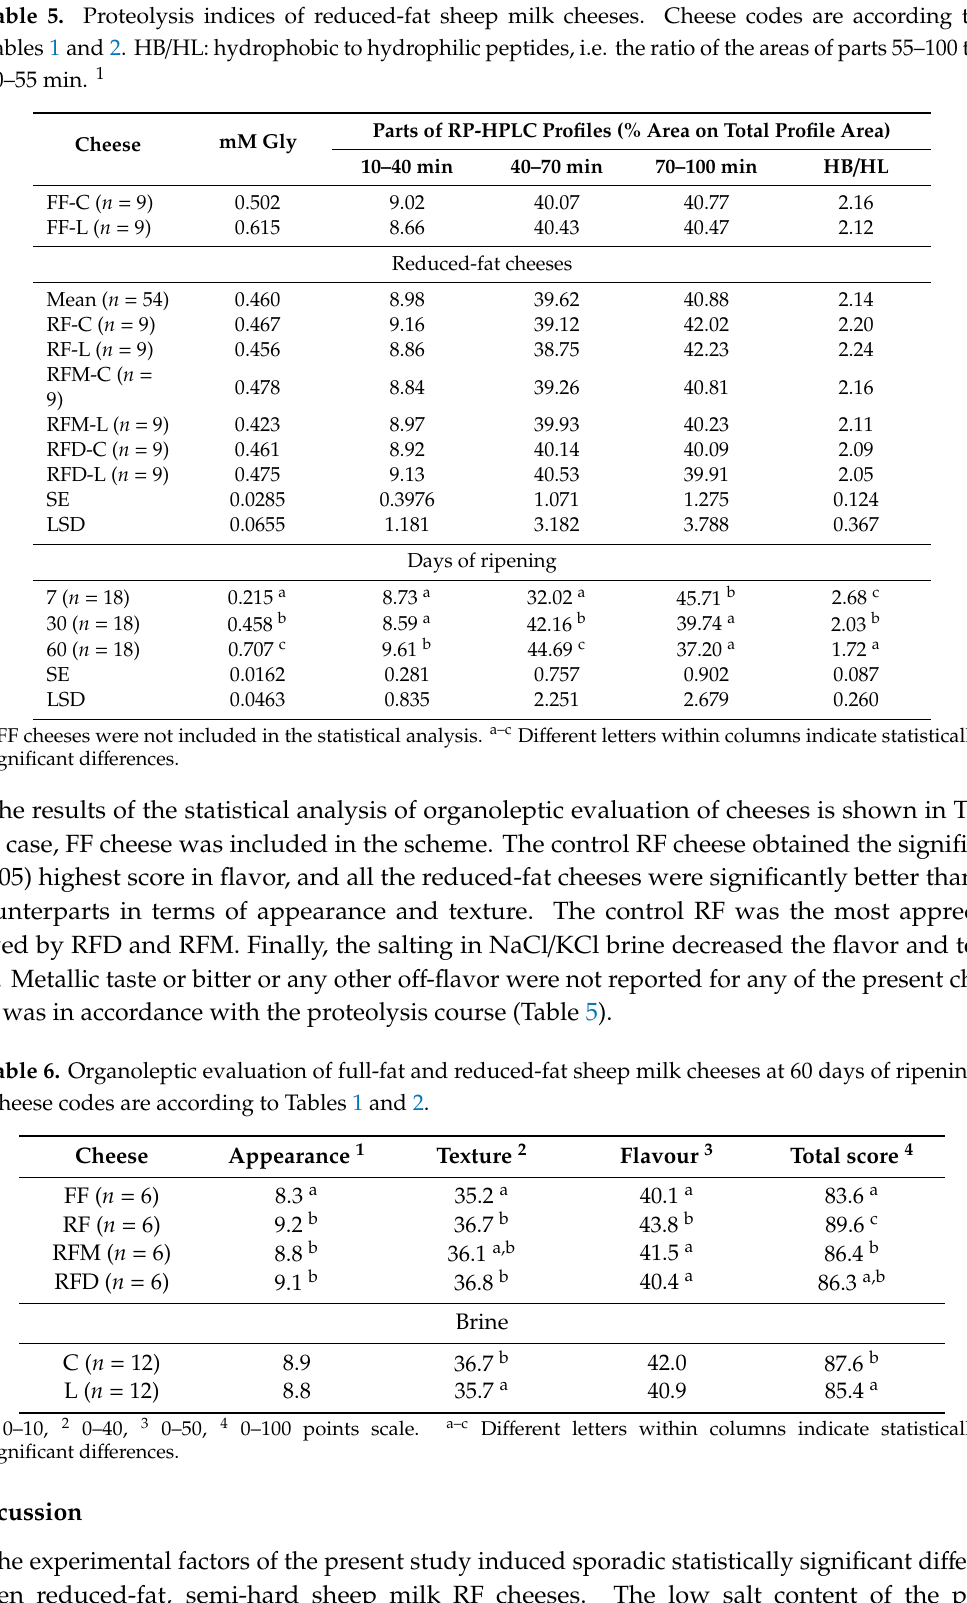
Table 5. Proteolysis indices of reduced-fat sheep milk cheeses. Cheese codes are according to Tables 1 and 2. HB / HL: hydrophobic to hydrophilic peptides, i.e. the ratio of the areas of parts 55–100 to